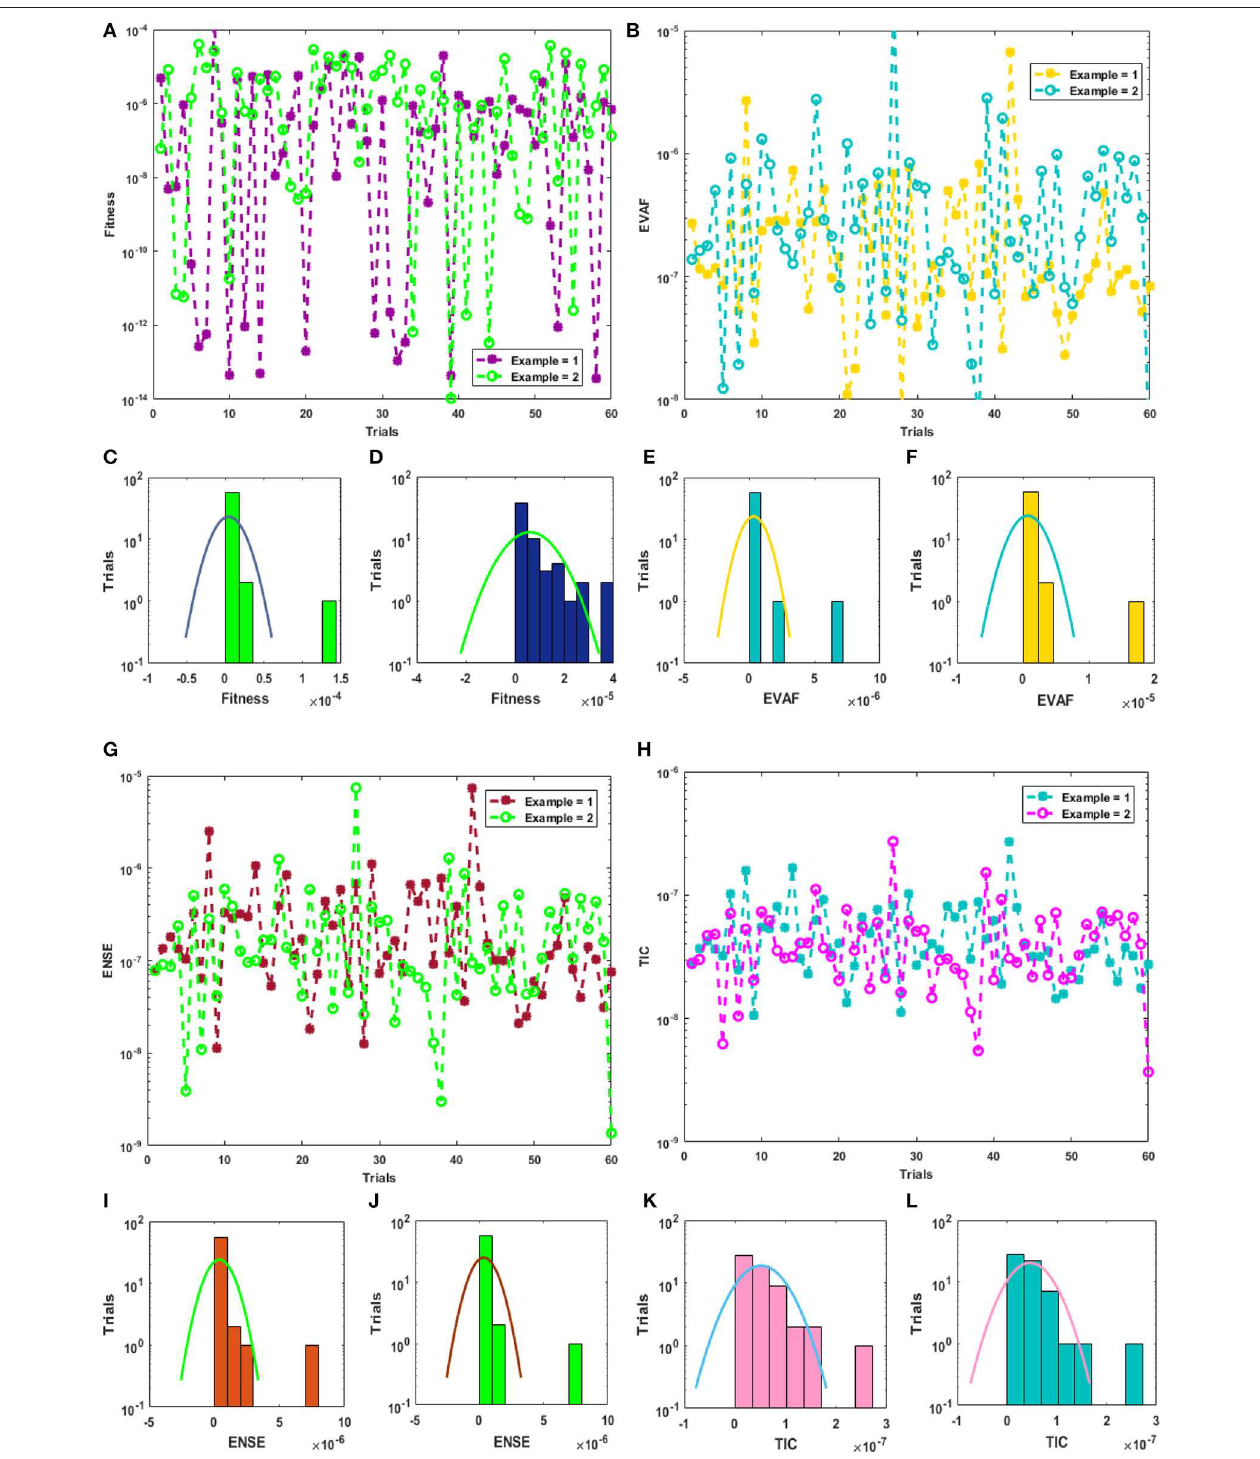
FIGURE 4 | Statistical analysis for Fitness, EVAF, ENSE, and TIC values along with the histograms for 10 numbers of neurons. (A) Analysis through Fitness values. (B) Analysis through EVAF values. (C) Fitness histogram for Example 1. (D) Fitness histogram for Example 2. (E) EVAF histogram for Example 1. (F) EVAF histogram for Example 2. (G) Analysis through ENSE values. (H) Analysis through TIC values. (I) ENSE histogram for Example 1. (J) ENSE histogram for Example 2. (K) TIC histogram for Example 1. (L) TIC histogram for Example 2.